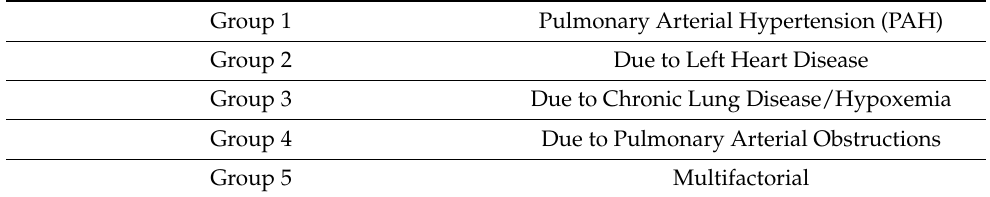
Table 1. Different groups of pulmonary hypertension. Left column indicates group of pulmonary hypertension and right column shows the entity